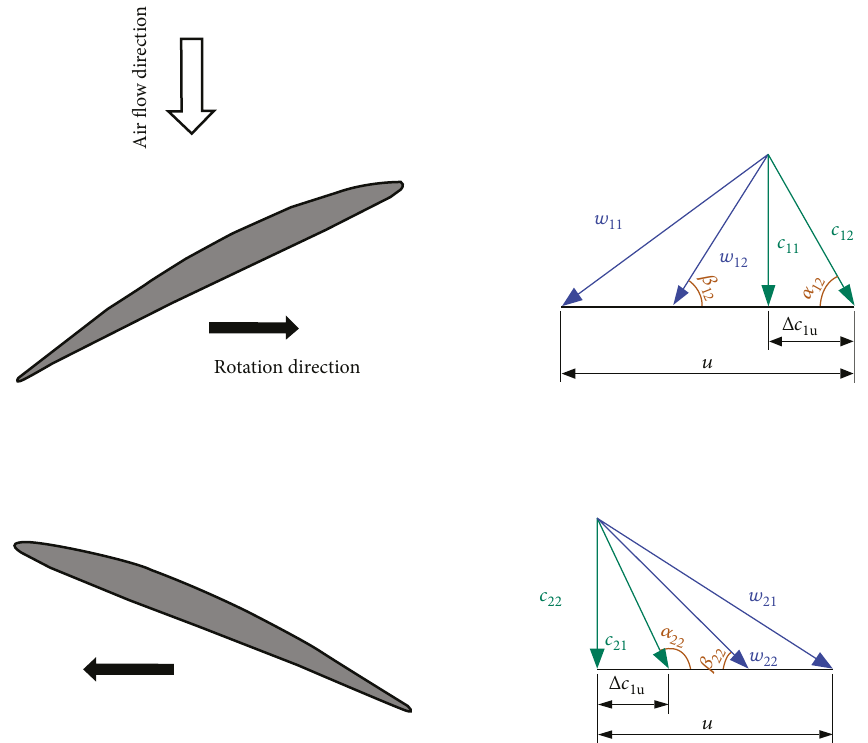
Figure 6: Velocity triangles for the contrarotating